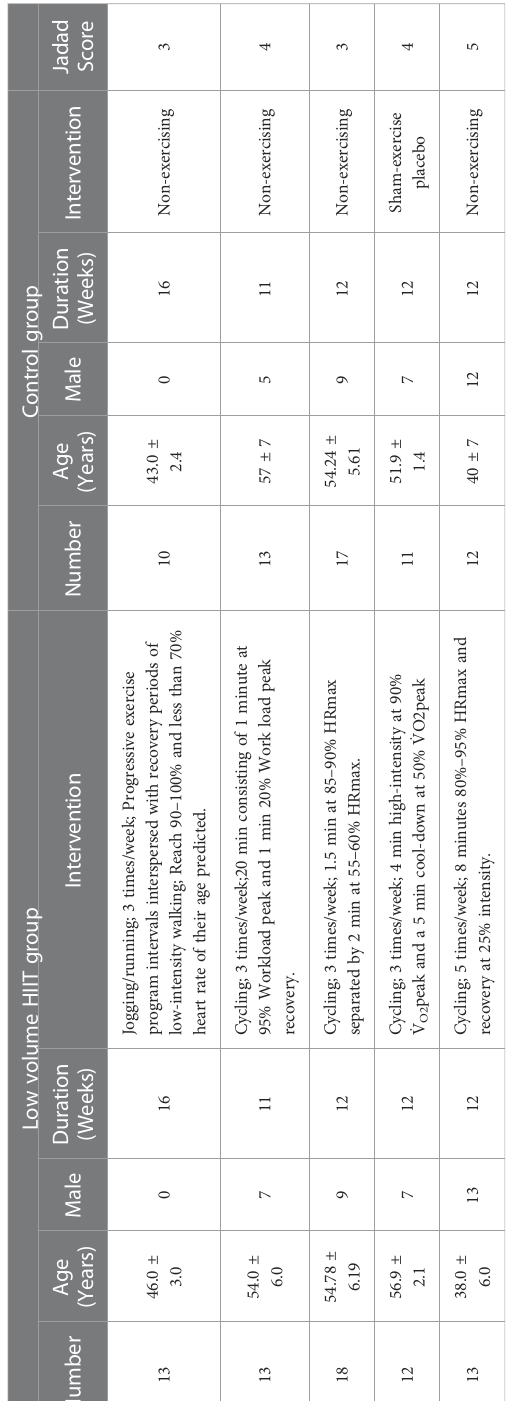
Figure 7A), and there was a signi fi cant level of heterogeneity (I 2 = 99%, P <0.00001). However, after excluding one study, LVHIIT was found to signi fi cantly reduce total cholesterol (RR = -0.24, 95% CI = -0.35 to -0.13, p<0.0001; Figure 7B), and the heterogeneity became nonsigni fi cant (I 2 = 0%, P =0.68). For high-density lipoprotein, the meta-analysis showed that there was a signi fi cant difference between the LVHIIT group and the control group (RR = 0.21, 95% CI = 0.08 – 0.33, p=0.001; Figure 7E), and there was a signi fi cant level of heterogeneity (I 2 = 62%, P=0.05). After removing the study by Way et al., the results still showed that LVHIIT increased plasma HDL levels (RR = 0.28, 95% CI =0.24 — 0.32, p<0.00001), but the heterogeneity was nonsigni fi cant (I 2 = 0%, P =0.58; Figure 7F). Overall, LVHIIT can reduce TC, LDL and triglyceride levels and increase HDL levels.